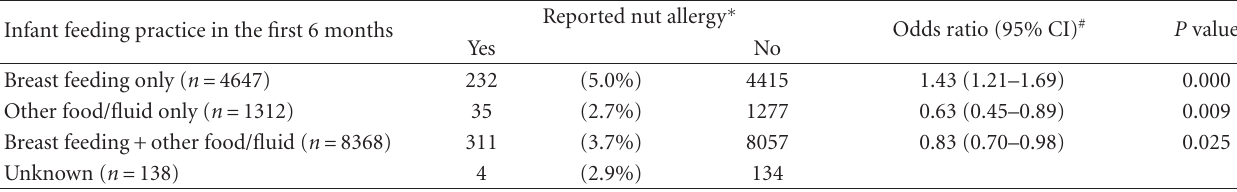
Table 1: Odds ratios for reported nut allergy and infant feeding practices of kindergarten children in the Health Check Questionnaire 2006–2009.